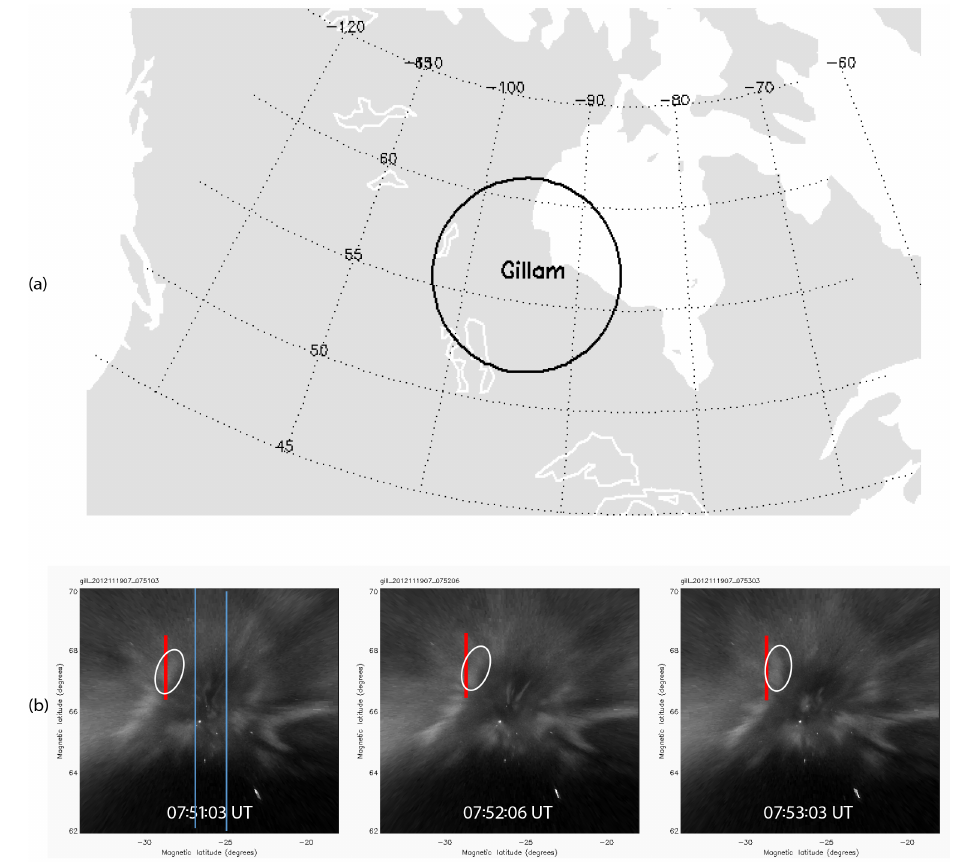
Figure 1. (a) Map of the location of THEMIS-ASI Gillam station. The black circle gives the coverage of the station. (b) Three all-sky images at an interval of about 1min. The white circle indicates a PPA patch. The red line as a reference gives the location of the patch at